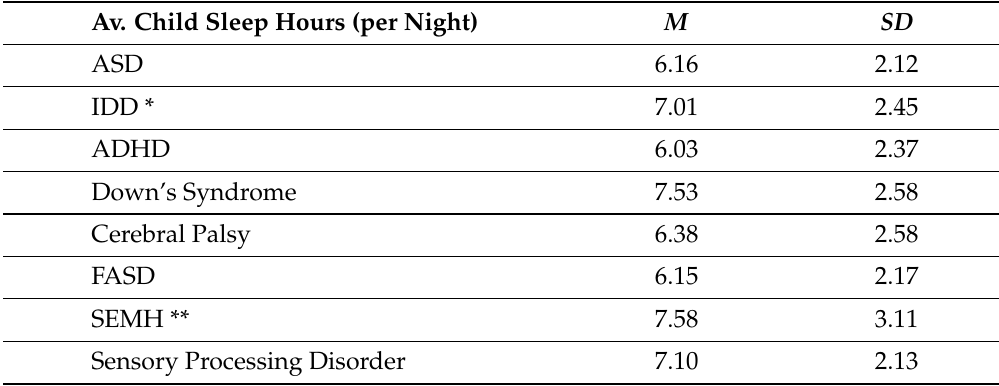
Table 3. Average Nocturnal Sleep Duration of